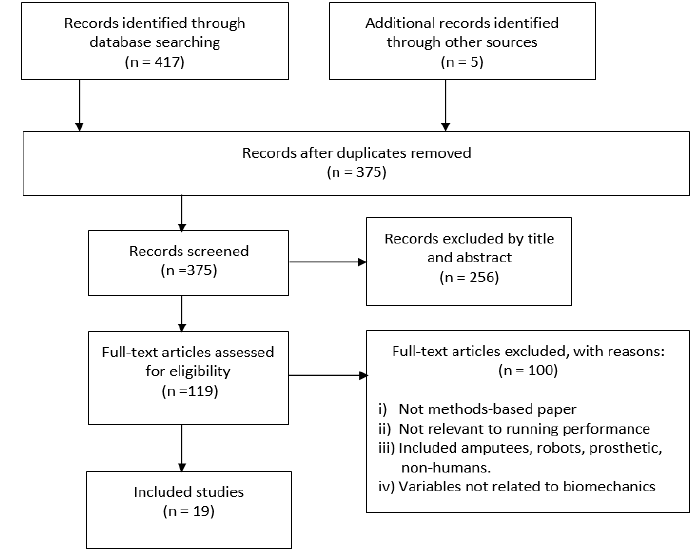
Figure 1. Flow diagram of study selection.